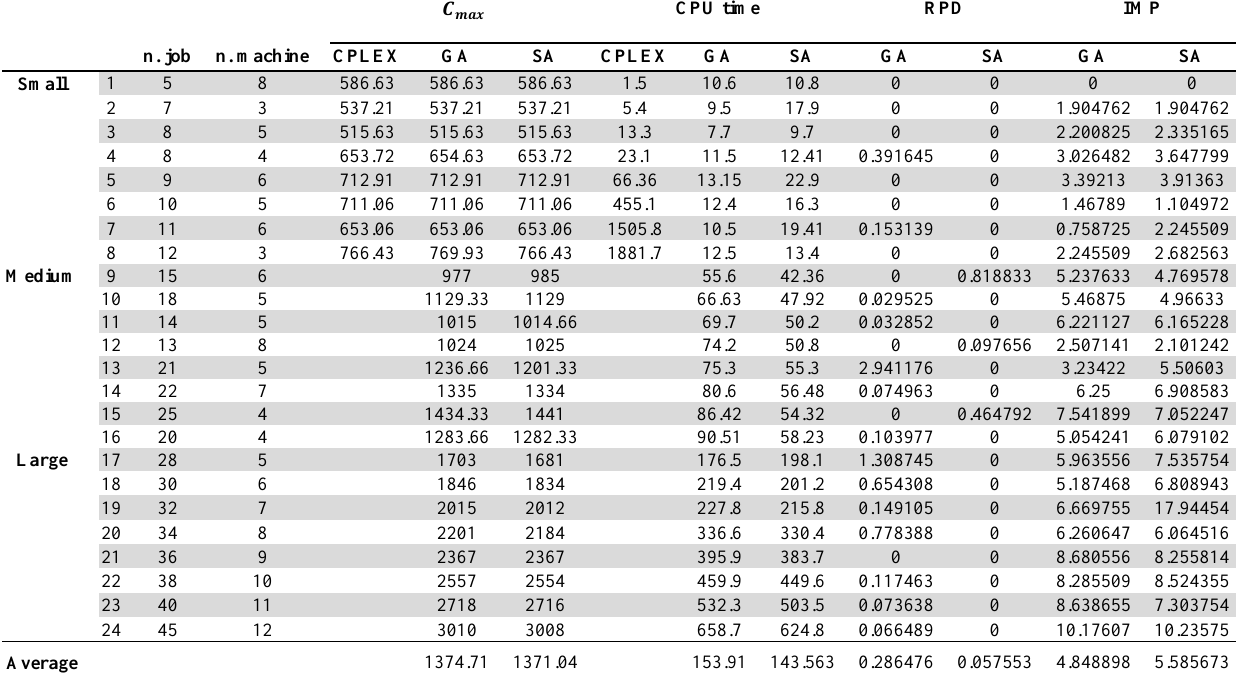
Computation results obtained by the proposed algorithms and CPLEX based on problem type and dimensions